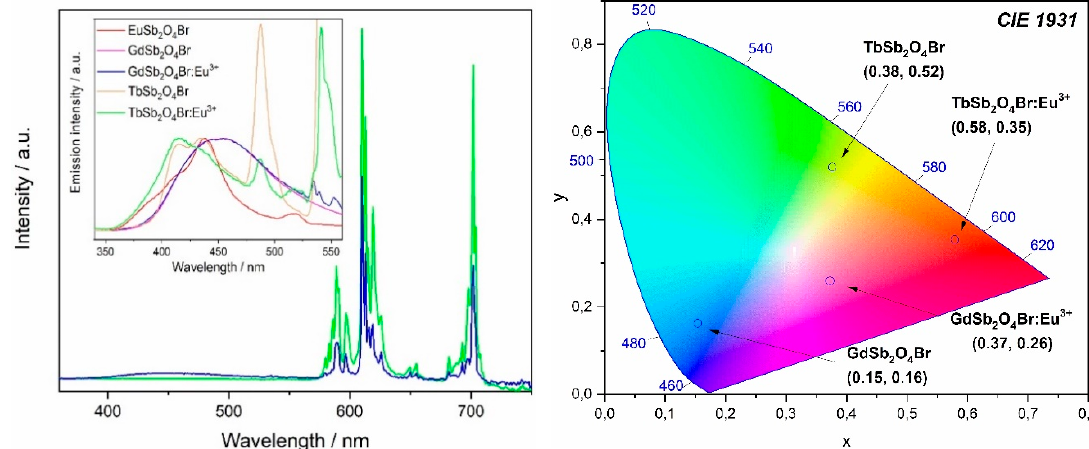
Figure 11. Left : emission spectra of TbSb 2 O 4 Br:Eu 3+ (green line) and GdSb 2 O 4 Br:Eu 3+ (blue line) at λ ex = 257 nm. Inset: comparison of emission in the Sb 3+ region for all the compounds upon the same excitation. These spectra were normalized for the respective Sb 3+ emission maximum of each compound. Right : Commission internationale de l’éclairage (CIE) diagram (CIE 1931) for TbSb 2 O 4 Br, TbSb 2 O 4 Br:Eu 3+ , GdSb 2 O 4 Br, and GdSb 2 O 4 Br:Eu 3+ at λ ex = 257 nm.